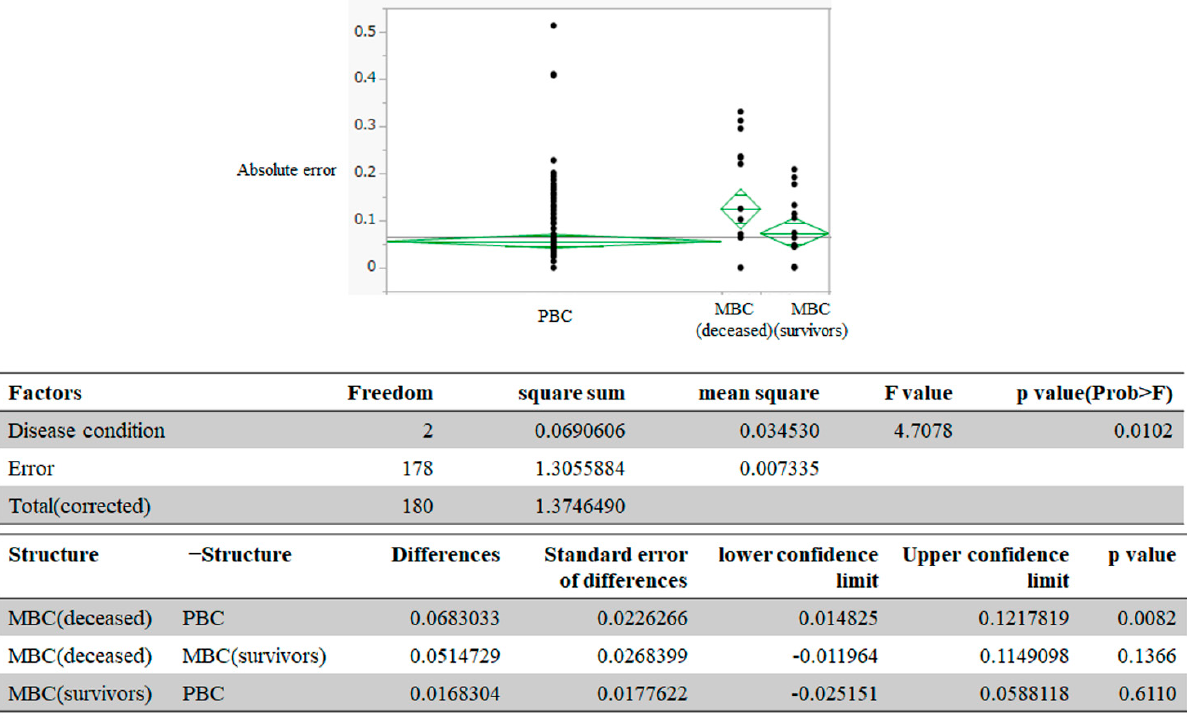
Figure 4. Examination of between-group differences of health state utility values: MBC, metastatic breast cancer; PBC, primary breast cancer. Black dots indicate each data of absolute error.